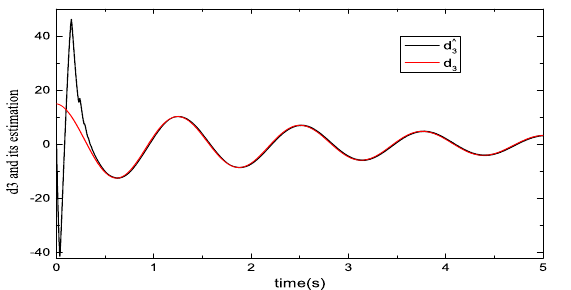
Figure 4. Performance evaluation curves for four unknown disturbance observers: disturbance of motor 3 and its estimated value.